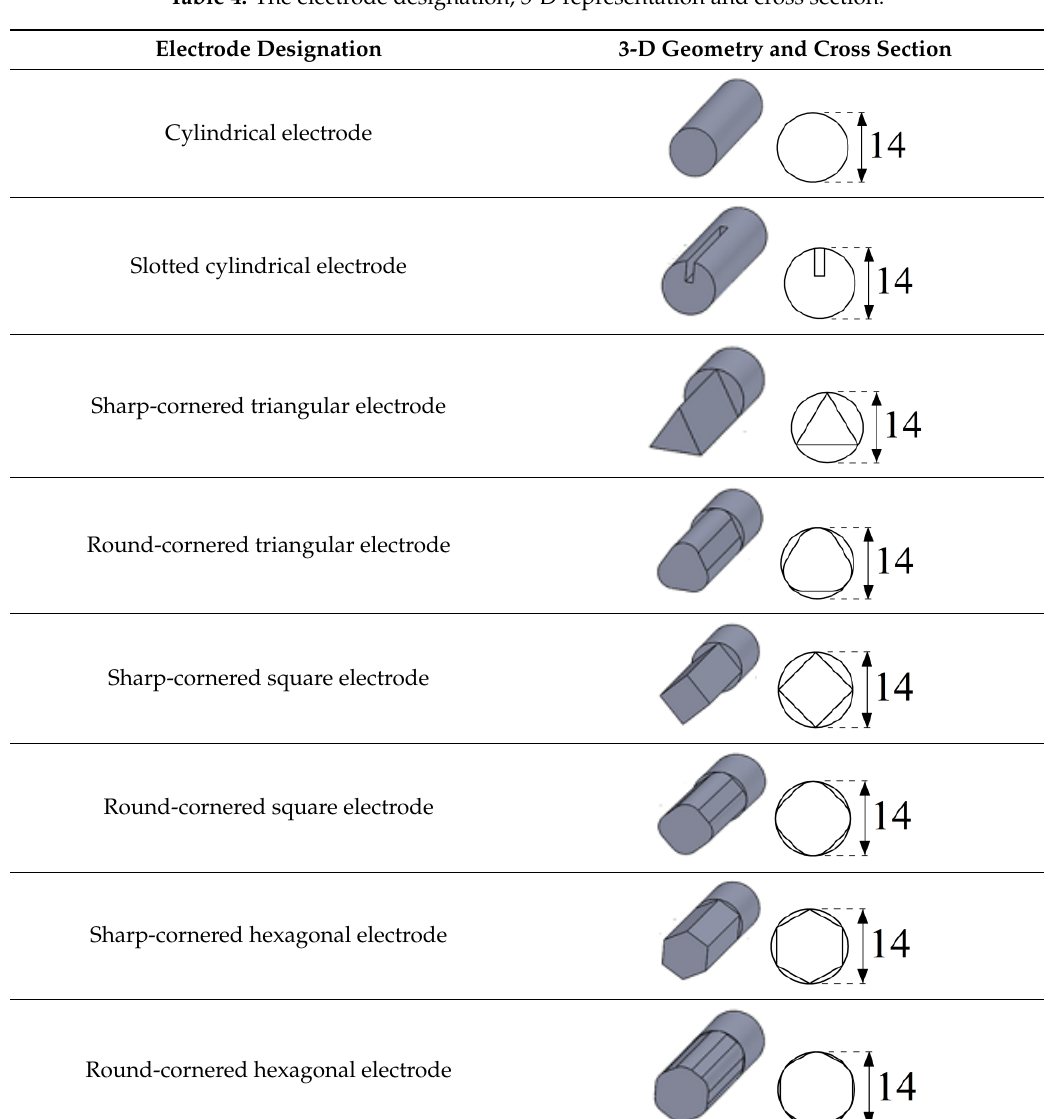
Balance Table 2. The physical properties of Ti6Al4V titanium alloy. Density,  (g/cm 3 )